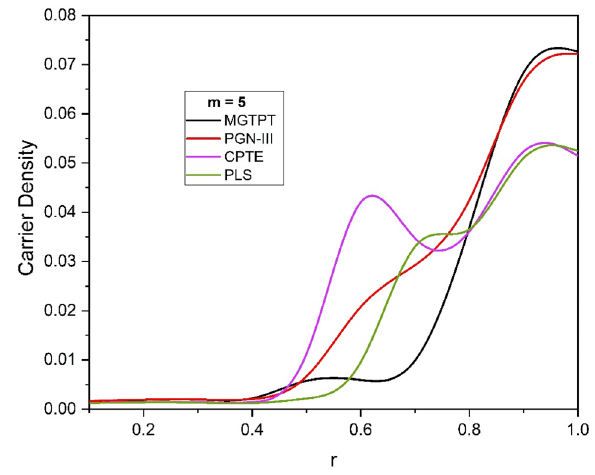
Fig. 7 The change of displacement for various models with Hall effect